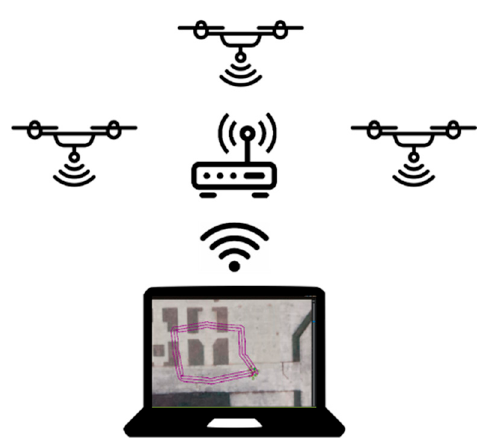
Figure 11. Monitoring station.